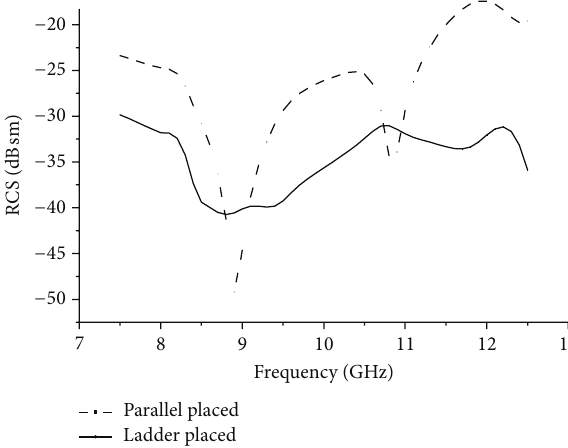
Figure 8: RCS with the frequency of eight-element arrangement .